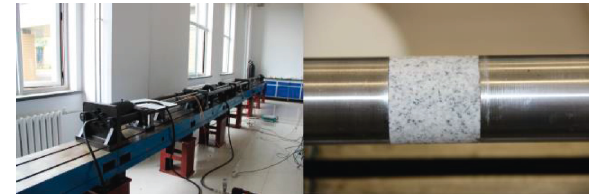
Figure 1: Split Hopkinson pressure bar test device.